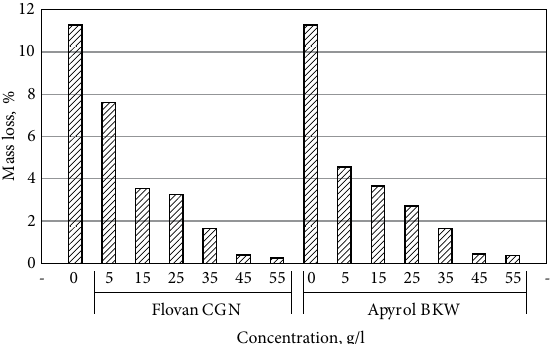
Fig. 7. Mass loss of hemp fiber composite during